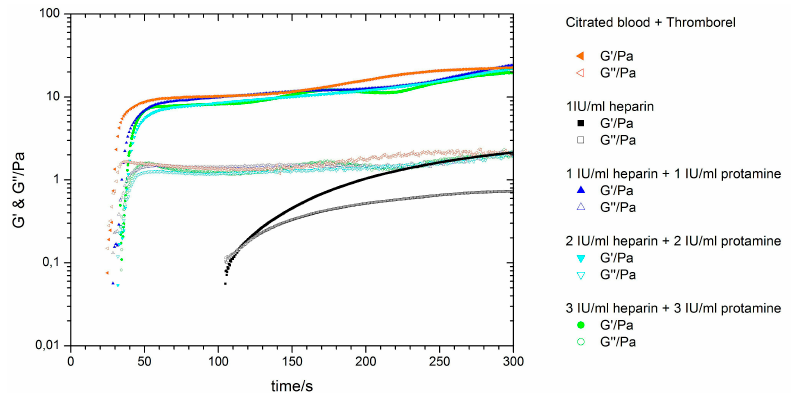
Figure 3. Citrated blood was heparinised and antagonised with protamine before activation with Thromborel. The effect of the inhibitor heparin was reversed by the equivalent amount of protamine. Citrated blood (orange) and a heparinised (1 IU/mL) citrated blood (black) activated with Thromborel were the reference measurements. All protamine-neutralised heparin concentrations provided results comparable to the reference measurement of citrated blood without heparin (orange) ( n = 5). Table 3. Citrated blood activated by Thromborel (Control) and various concentrations of heparin neutralised with the equimolar amount of protamine were equally activated by Thromborel ( n = 5). Summary of the clotting time (CT), elastic (G ′ ) and viscous (G ″ ) shear moduli at 300 seconds and linear slopes (m (G ′ ) and m (G ″ )). Sample Kinexus Pro KC 1A Kinexus Pro G (cid:48) (Pa)at 300